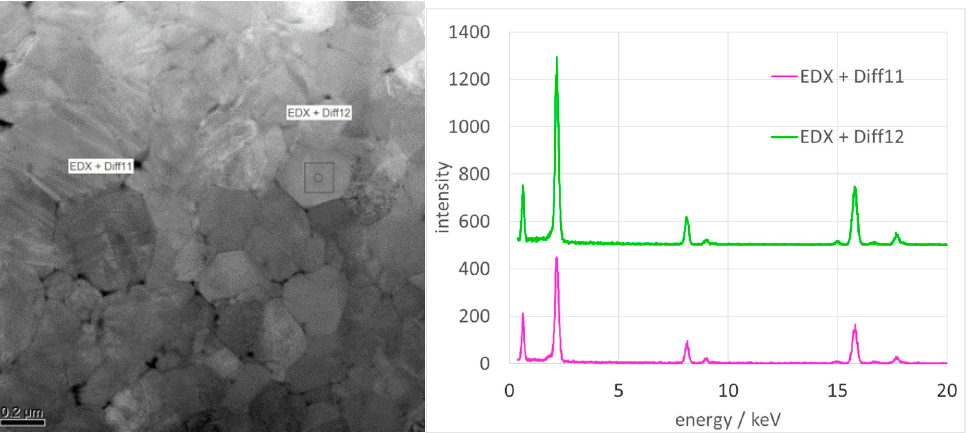
Figure 7. EDX-spectra of grains in the layer and next to the interface.